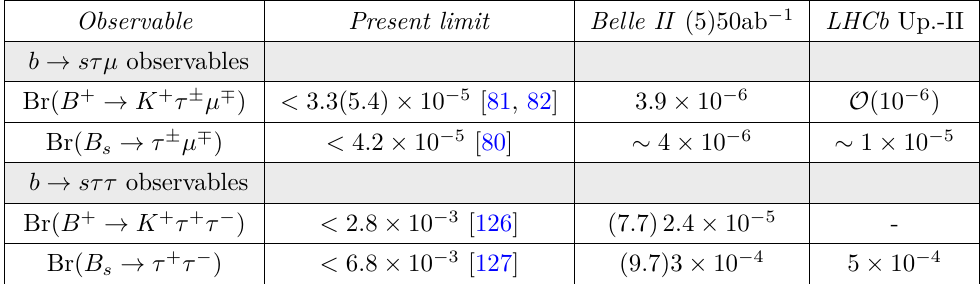
model (left panel) and in the S 1 + S (all) (right 3 3